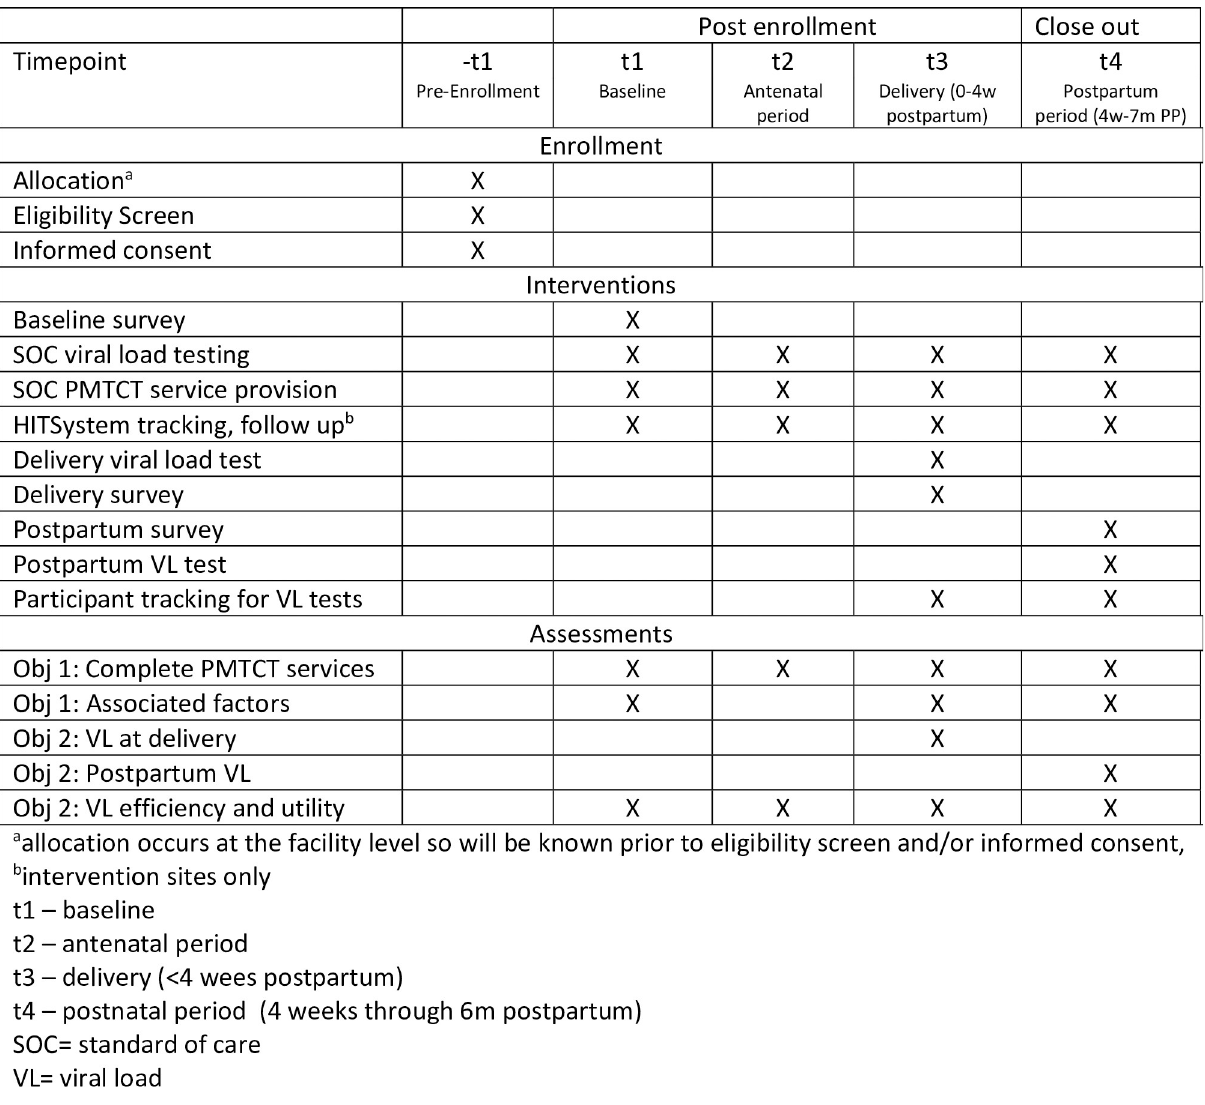
Fig 1. SPIRIT schedule of enrollment, interventions, and assessments.